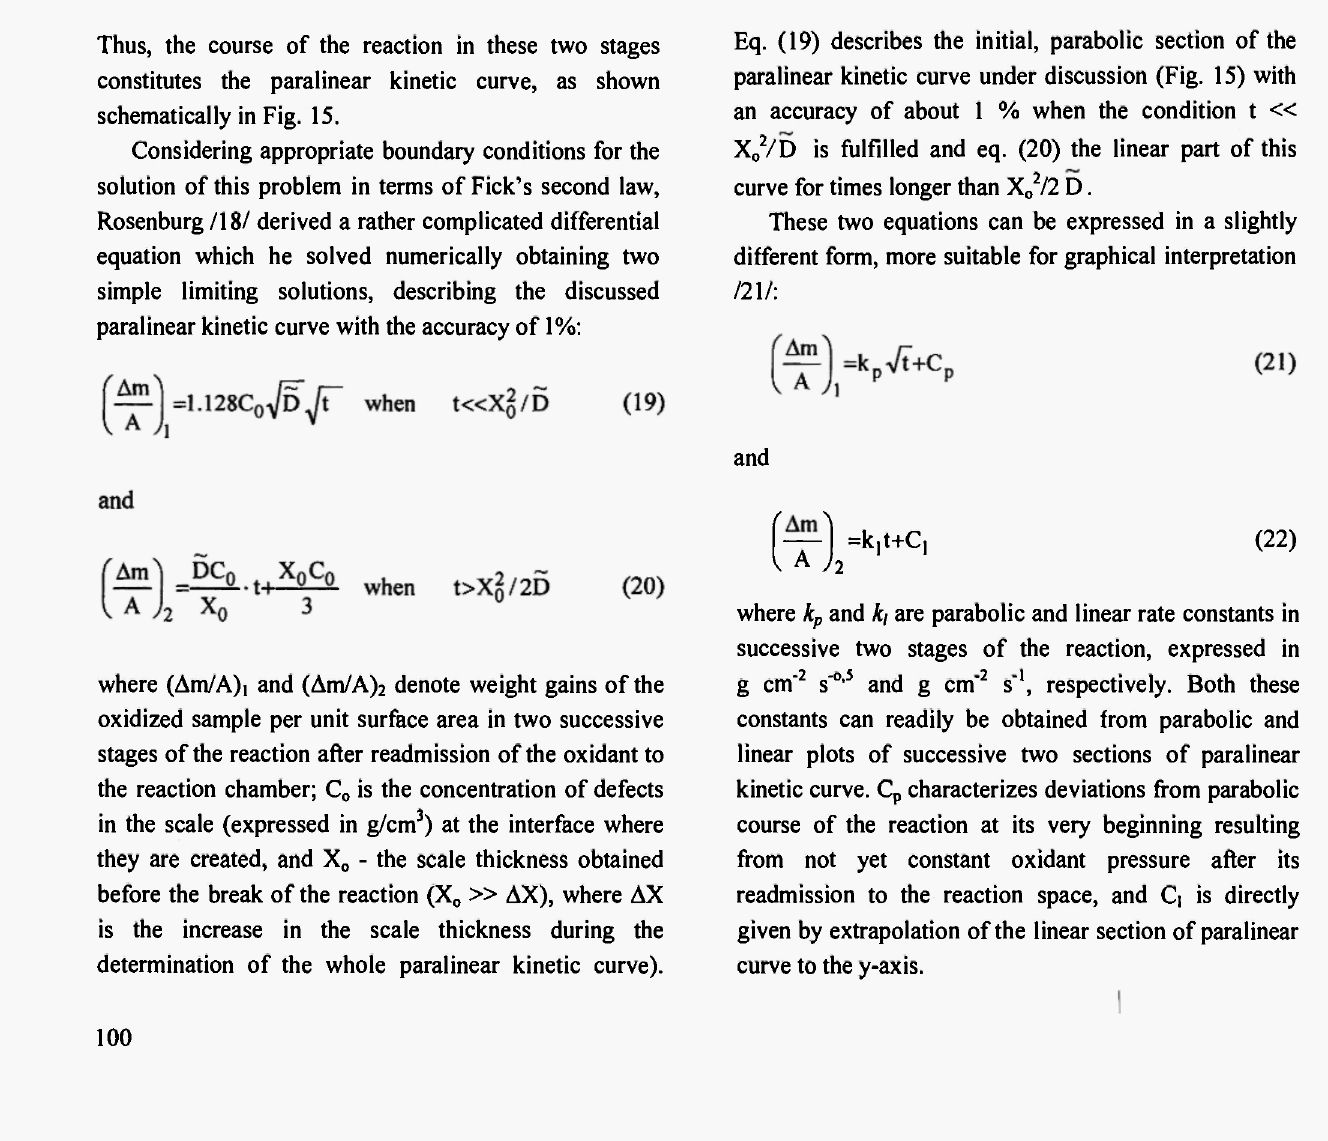
Fig. 14: Defect concentration changes (schematic) in the growing p- and η-type scales after re-admission of the oxidant to the reaction